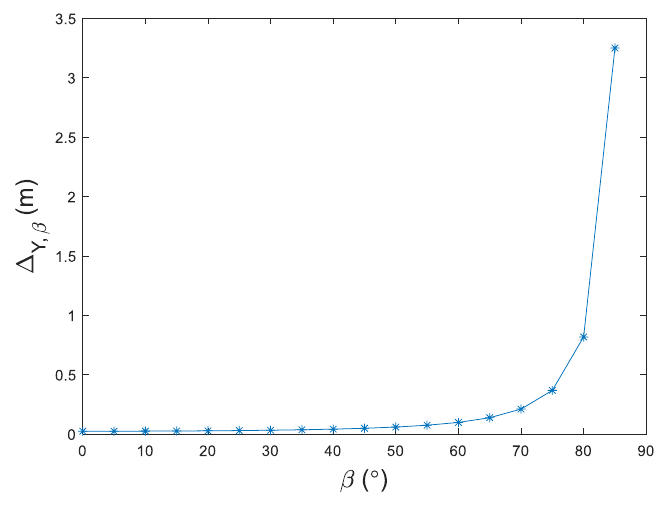
Figure 9. vs. azimuth  Figure 9. ∆ Y , β vs. azimuth β .